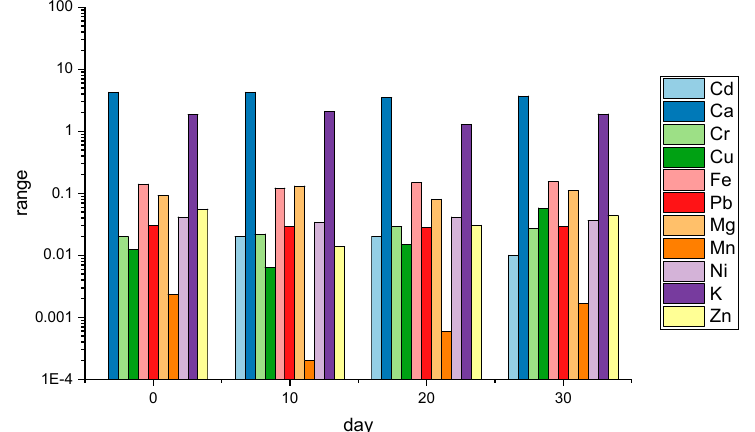
Figure 11. Concentration of heavy metals in rainwater (immediately after rainfall and 10, 20, 30 days after rainfall) used in the study.